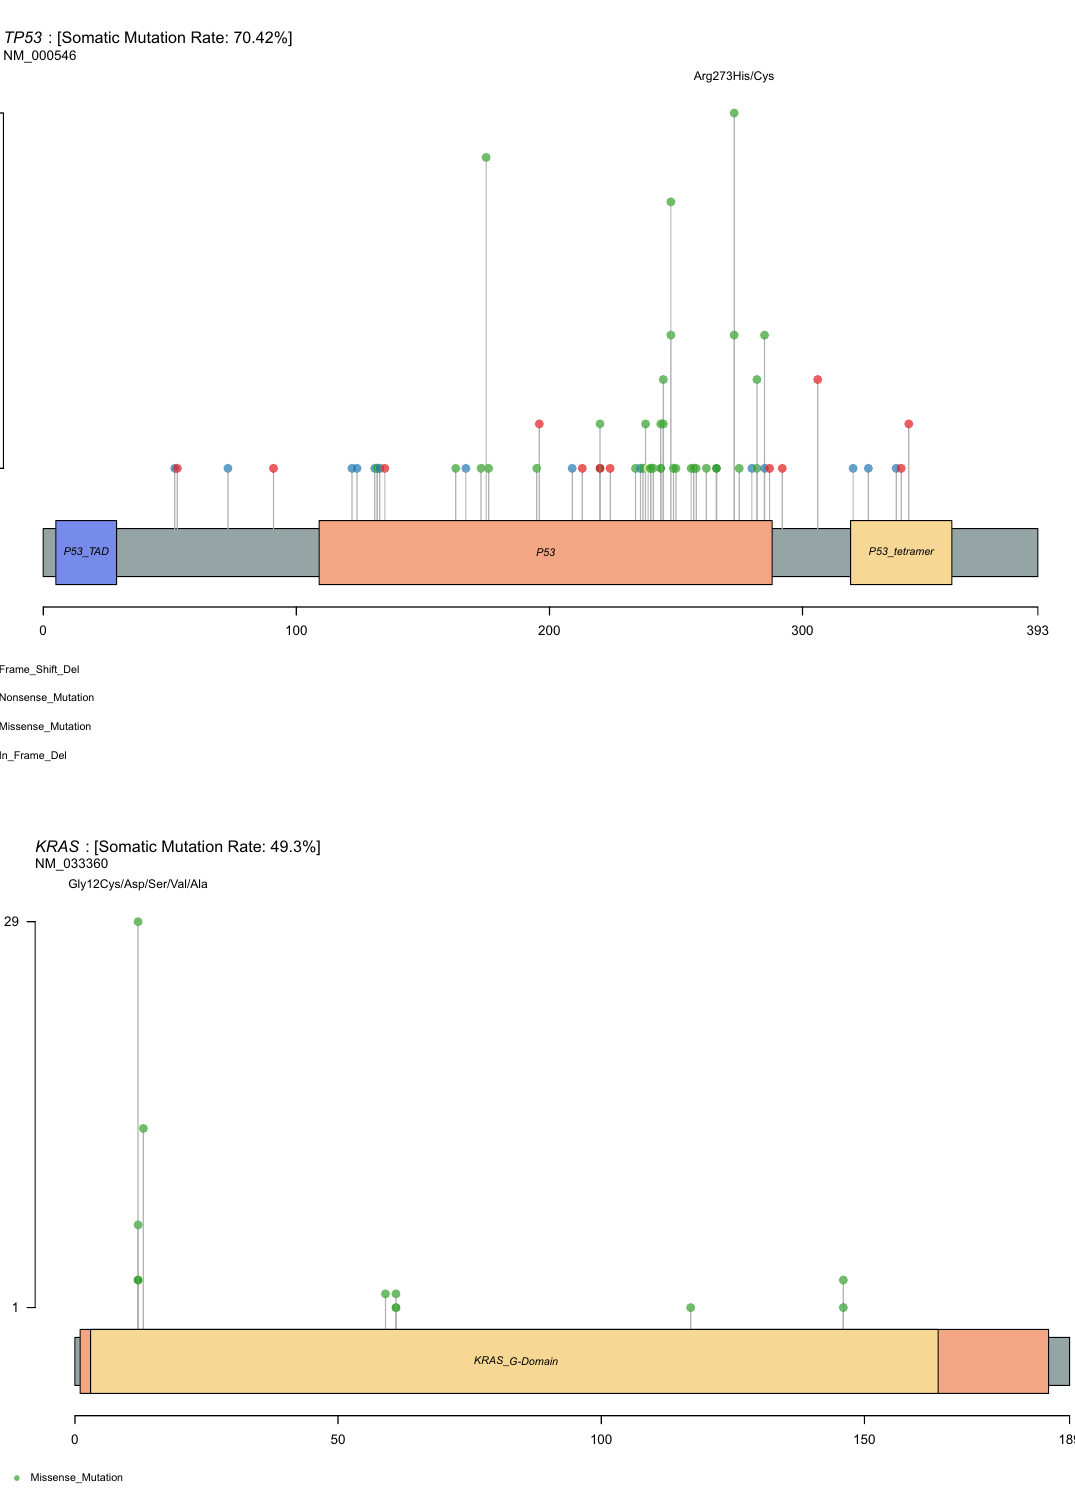
Figure 2. The variant prevalence and spectrum of TP53 ( A ), KRAS ( B ), APC ( C ), PIK3CA ( D ), SMAD4 ( E ) genes in this cohort. All graphs depict a lollipop plot showing identified variants relative to a schematic representation of the gene. Y-axis represent total number of mutations at each